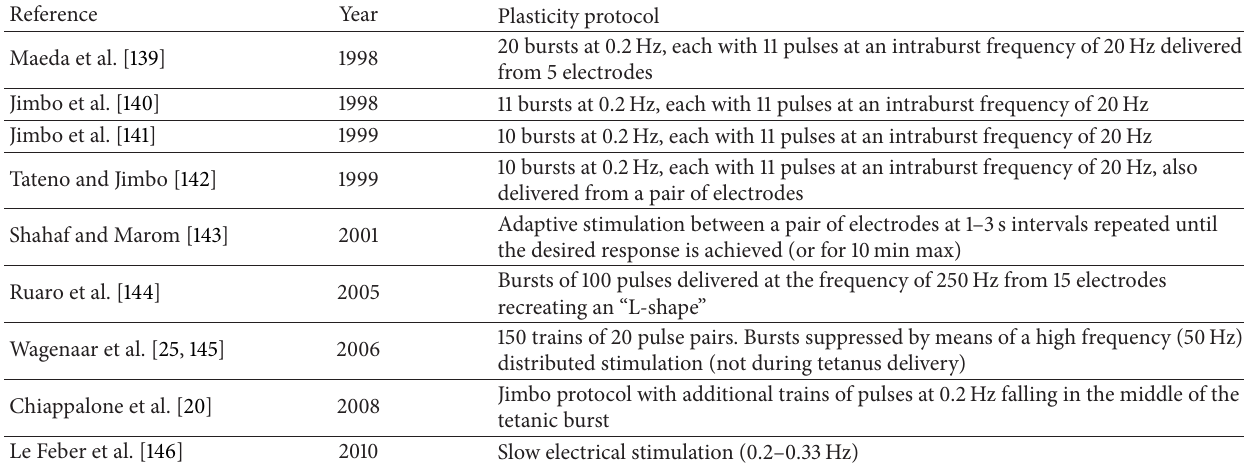
Table 1: Summary of the plasticity protocols used in mammalian neuronal